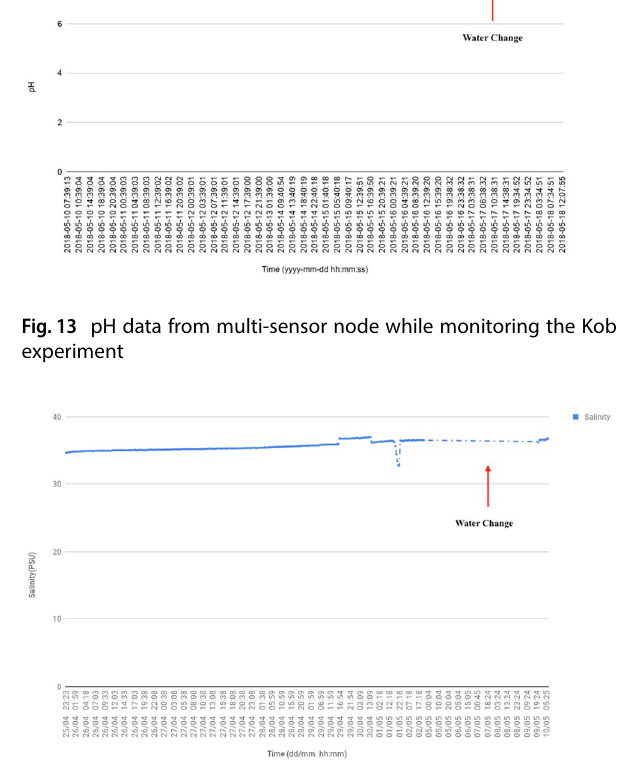
Fig. 14 Salinity data from multi-sensor node while monitoring the Tilapia experiment